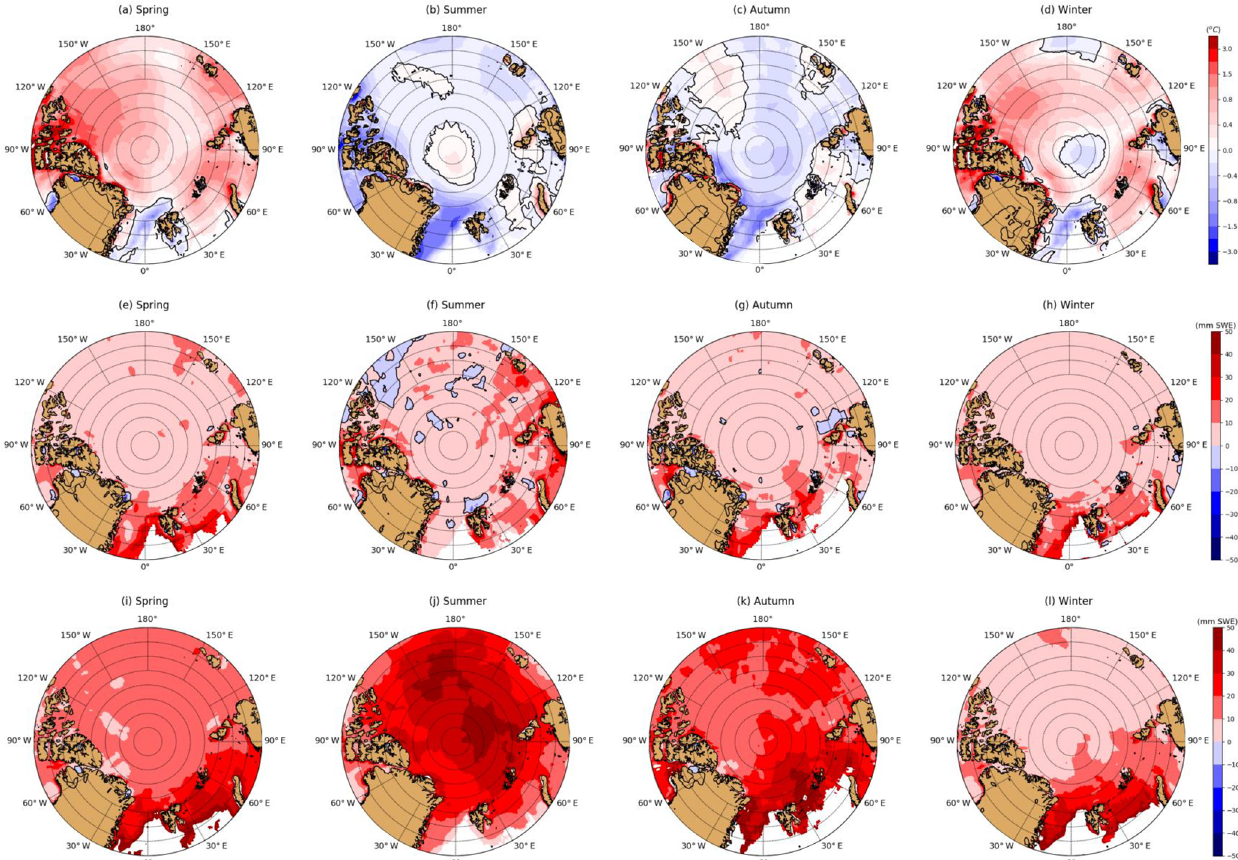
Figure 2. Seasonal mean difference between ERA5 and ERA-I (ERA5-ERA-I) for T2M (a–d) , total precipitation (e–h) and snowfall (i–l) in spring (a, e, i) , summer (b, f, j) , autumn (c, g, k) and winter (d, h, l) over Arctic sea ice during 2010–2015. Table 2. The mean T2M, accumulated FDD and estimated ice growth with the FDD model. Buoy T2M mean ( ◦ C) FDD (Kd) a /ice growth (m) b ERA5 ERA-I Buoy ERA5 ERA-I Buoy 2011M − 22 . 5 − 24 . 2 − 26 . 6 4295/1.70 4662/1.78 5174/1.90 2012H − 22 . 5 − 24 . 1 − 25 . 8 4276/1.70 4624/1.78 4978/1.85 2012L − 22 . 1 − 23 . 1 − 24 . 9 4198/1.68 4402/1.73 4788/1.81 2012J − 20 . 8 − 20 . 8 NA 3902/1.61 3921/1.61